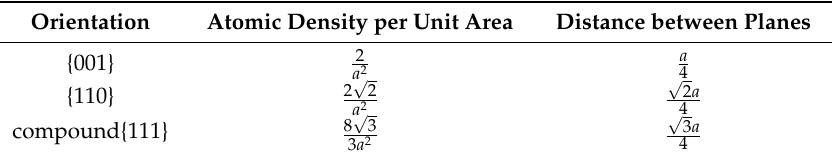
a is the lattice constant of GaAs and a = 0.565